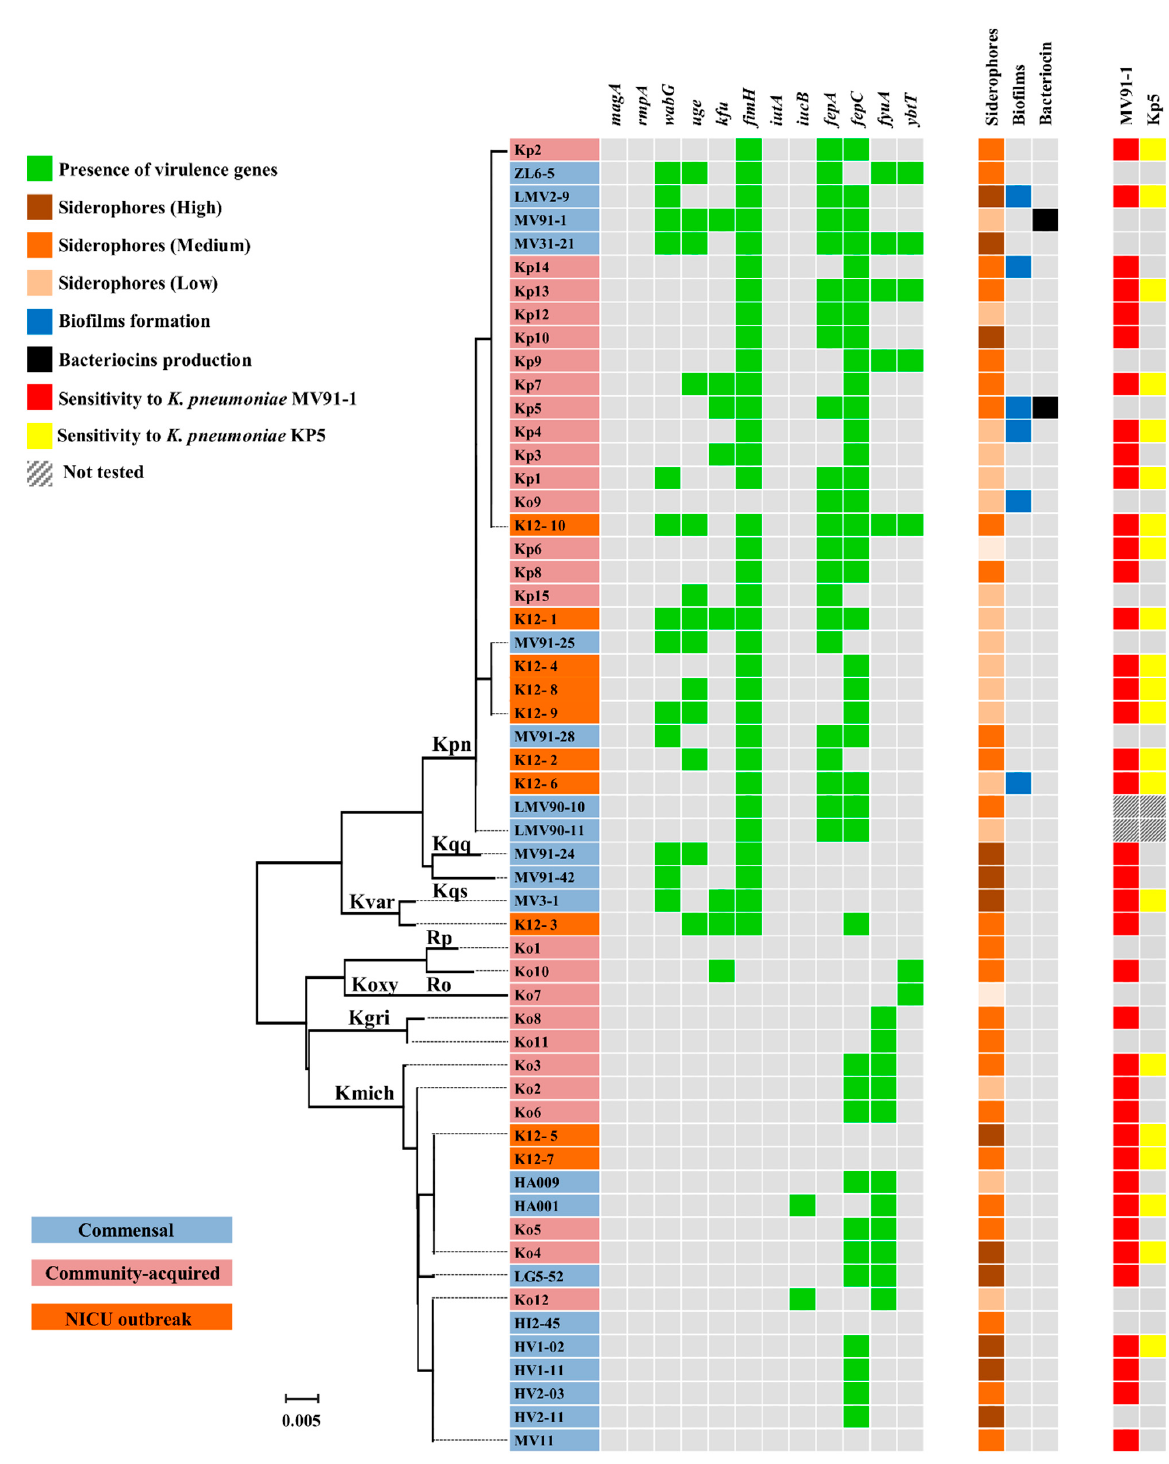
Figure 3. Virulence genes and phenotypic features of the Klebsiella isolates analysed in this study: The presence of genes involved in virulence, i.e., magA and rmpA (hypermucoviscosity phenotype), wabG (lipopolysaccharide synthesis), uge (uridine diphosphate galacturonate 4-epimerase), kfu (iron-uptake system), fimH (type 1 fimbrial adhesin), iutA (siderophore Aerobactin), iut B (receptor of Aerobactin), fepA (siderophore Enterobactin), fepC (receptor of Enterobactin), fyuA (siderophore Yersibactin), ybtT (receptor of Yersibactin), was determined by PCR. Production of siderophores was quantified in cell-free supernatants; biofilm formation was assayed and quantified in PVC microtiter plates; production of proteinaceous antimicrobial compounds (bacteriocins) was tested on solid culture medium against all Klebsiella isolates of this study, used as indicator strains. Sensitivity to bacteriocins produced by K. pneumoniae MV91-1 and Kp5 was assayed on solid